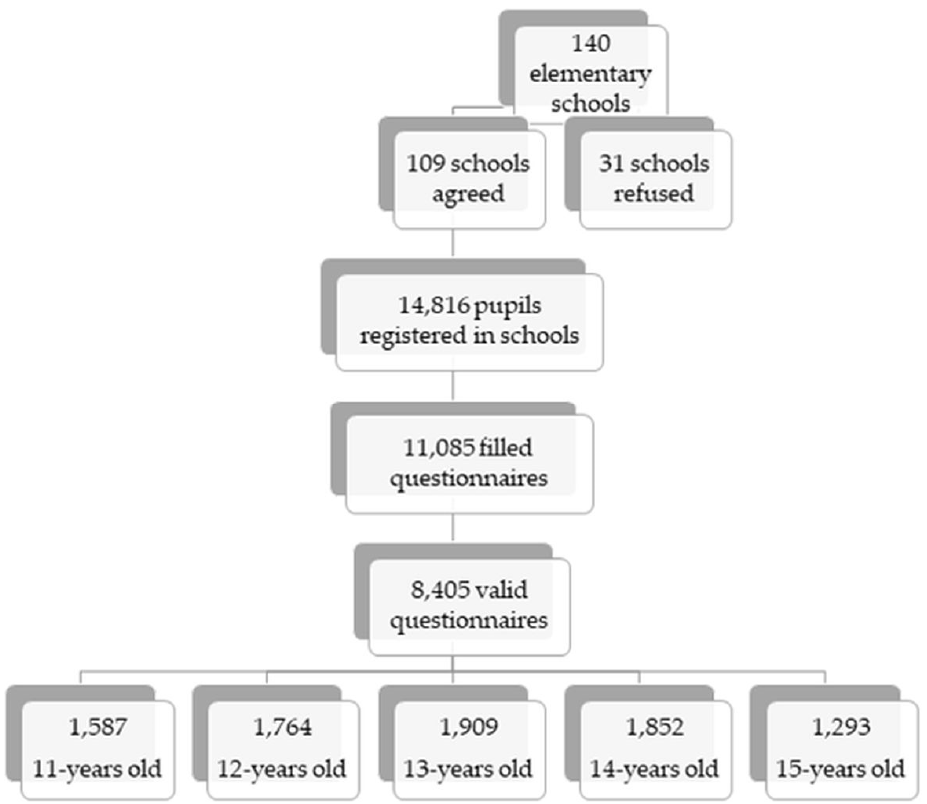
Figure 1. Two-step sampling